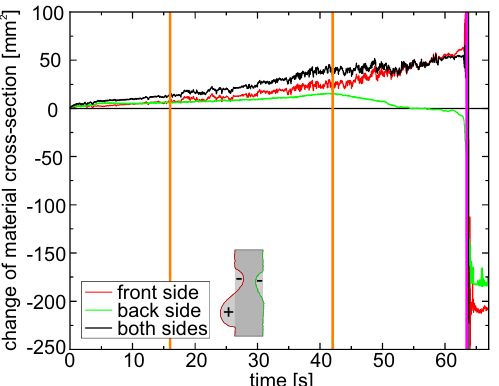
Figure 4. Temporal change of the material cross-section for the experiments in Figure 2. For both sample sides at the beginning an increasing material thickness is observed. For the front side this holds true until the perforation (magenta line), while for the back side, the sample thickness increases only until the melting (orange line, 42s), after which it decreases again. The global material cross-section increases until